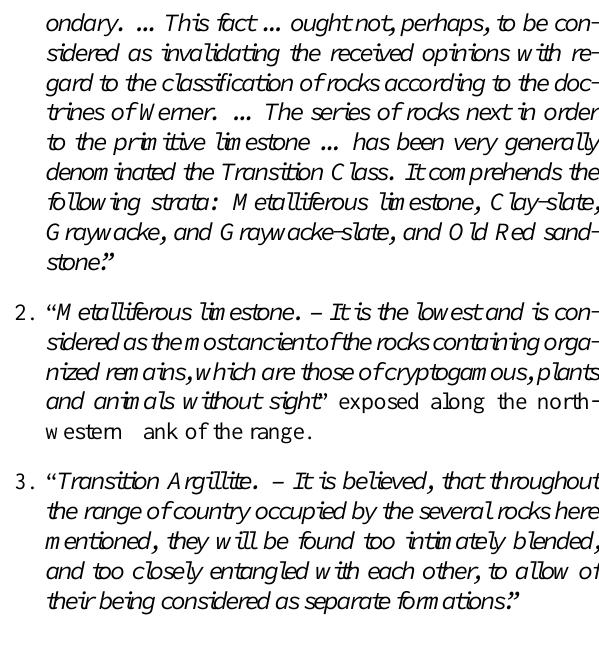
Figure 6. Hinton’s (1832) geologic map of the United States. In addition to rocks classified as “Primitive”, “Transition”, “Secondary” and “Alluvial Formations with Tertiary Beds”, Hinton delineates separately “Red Sandstone” and Argillaceous Sandstone” and “Trap Rocks” of the Chippewayan [Rocky]